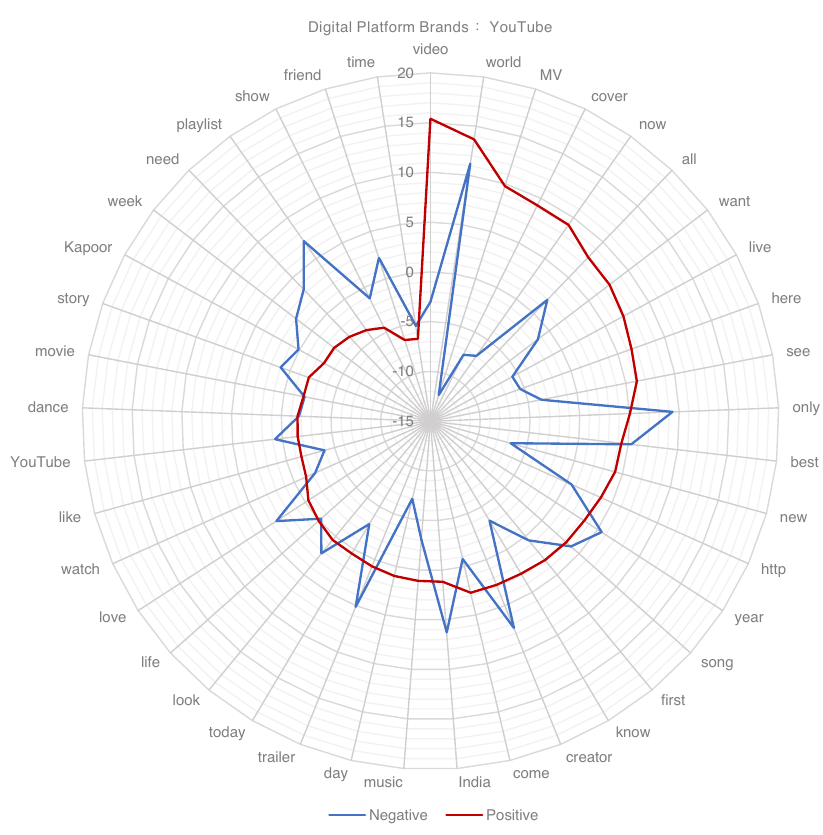
Fig. 9 Cues of YouTube, positive and negative clues in the postings on the “ YouTube ” fan